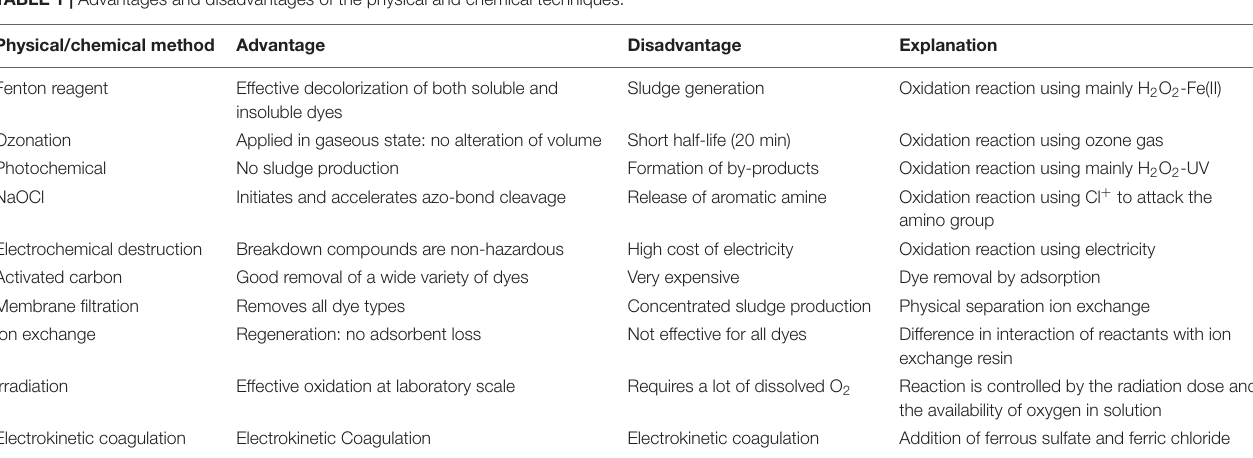
FIGURE 2 | A schematic diagram showing an integrated approach of interaction of dye with different approaches of degradation and intrinsic/extrinsic factors. TABLE 1 | Advantages and disadvantages of the physical and chemical